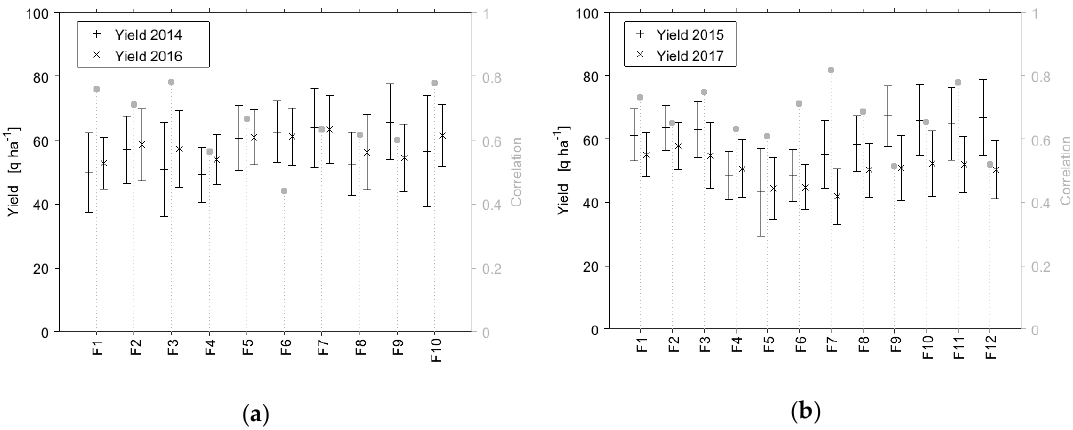
Figure 1. Overview of the wheat yield measurements collected at the intra-plot scale during the agricultural seasons 2014–2016 ( a ) and 2015–2017 ( b ). The mean and standard deviation values are presented together with correlation between “ pair years ” .